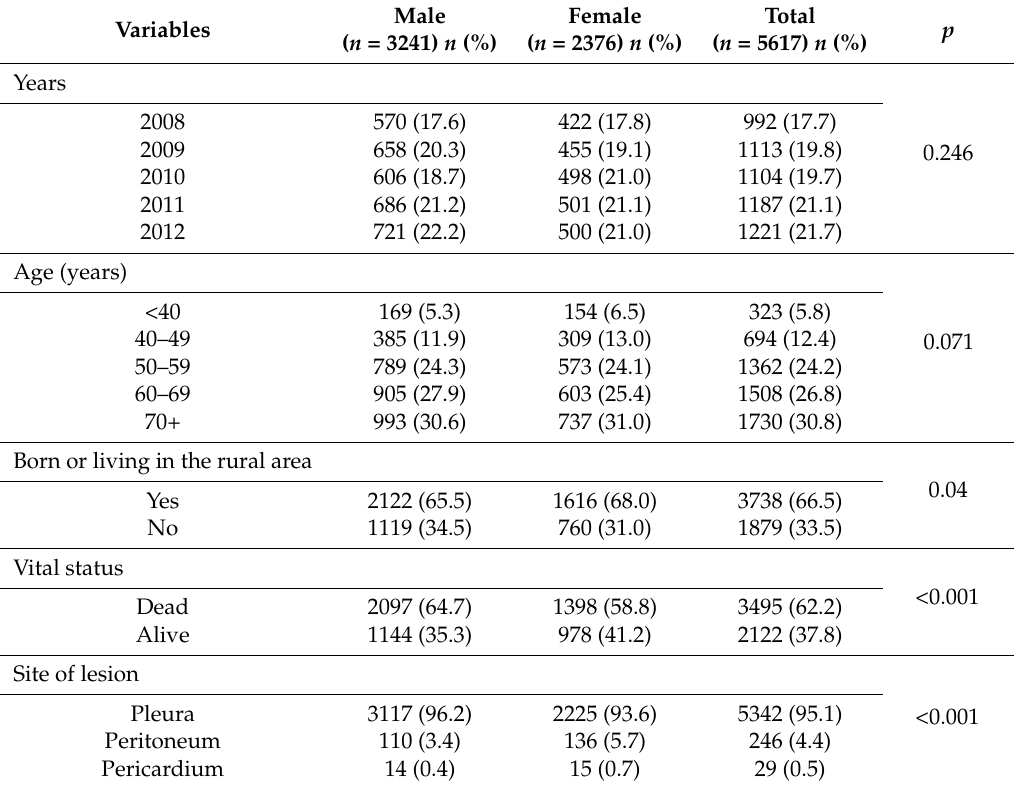
Table 1. Distribution of Turkey’s National Mesothelioma Surveillance detected cases by disease characteristics and